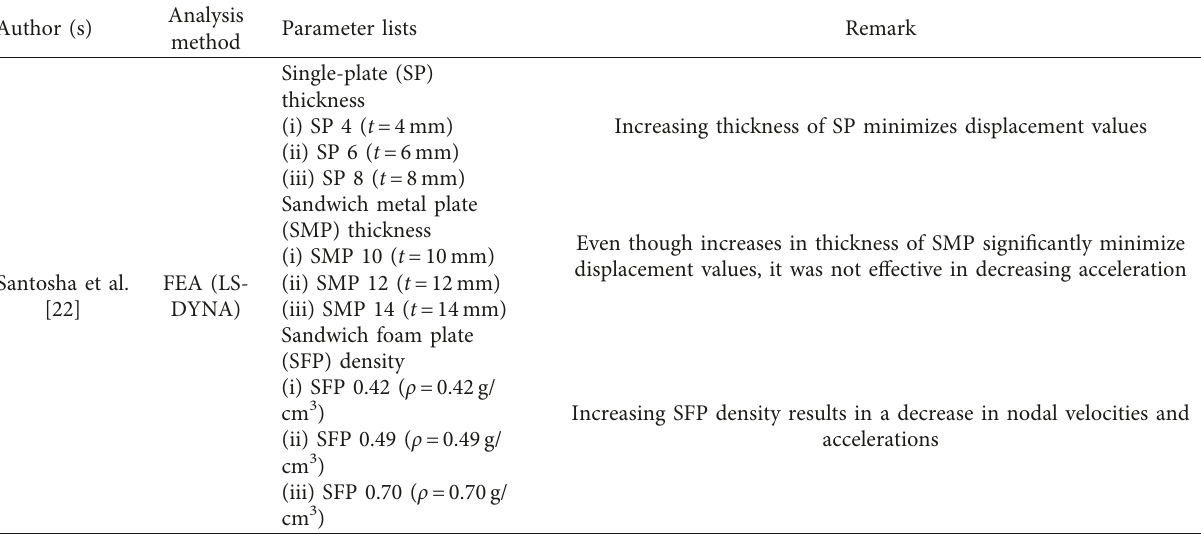
Table 8: Summary of different parameters and respective effects on metal-foam Sandwich panels prone to combined blast-fragment impact loads.